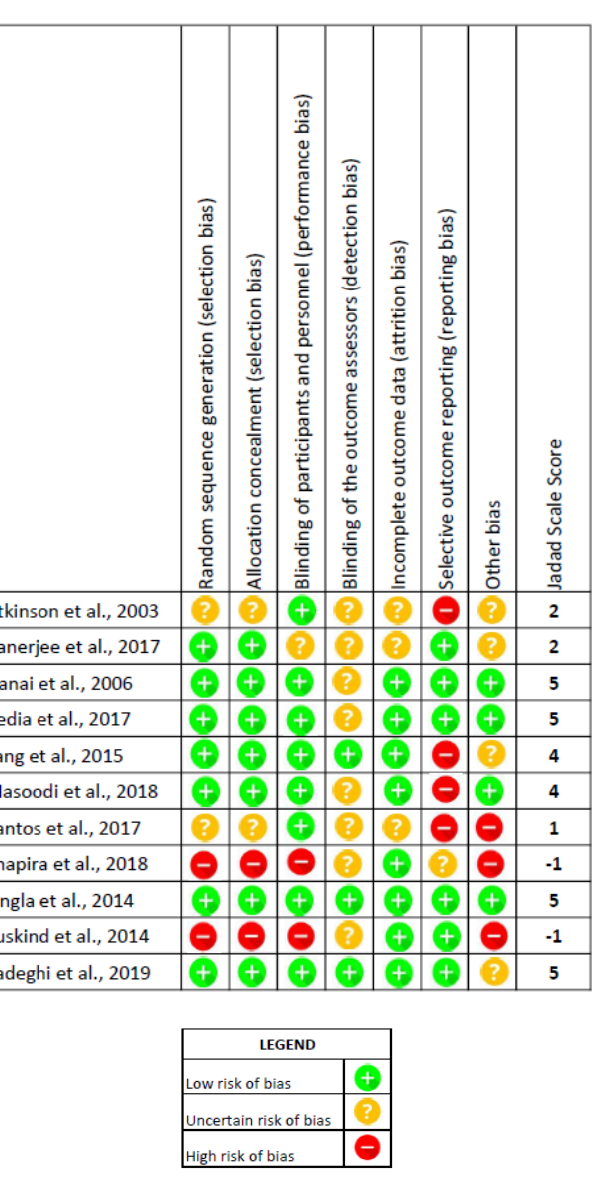
Figure 2. Bias risk assessment according to the Cochrane Handbook tool and the Oxford Quality Scoring System, the Jadad Scale.